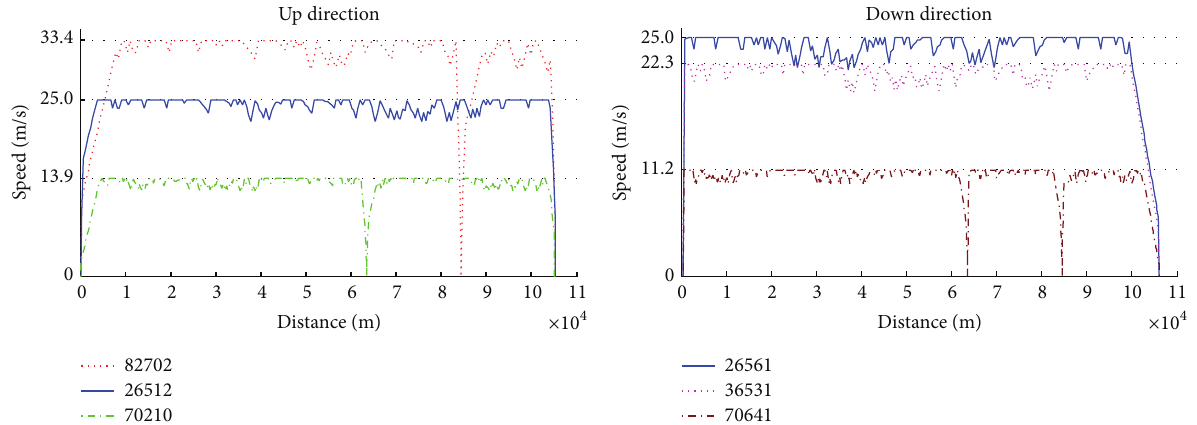
Figure 20: Train speed-distance curve (NCBS: blocking sections 3 ∼ 5 in the left).